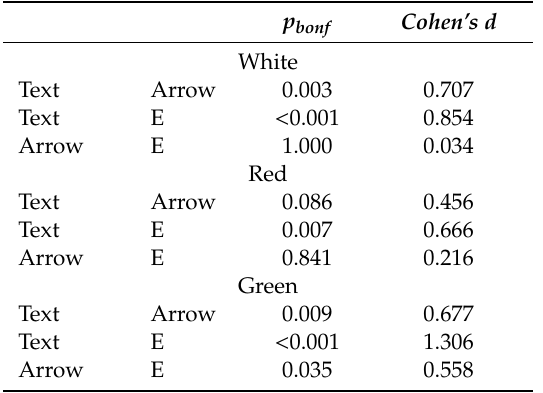
Table 8. Post-hoc comparisons analyzing the content type.